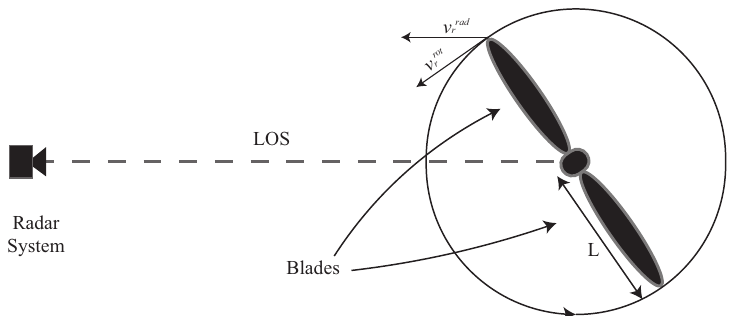
Figure 1. Simple scheme of a propeller’s speed measurement with radar. The length of the propeller is two times L , which represents the length of a